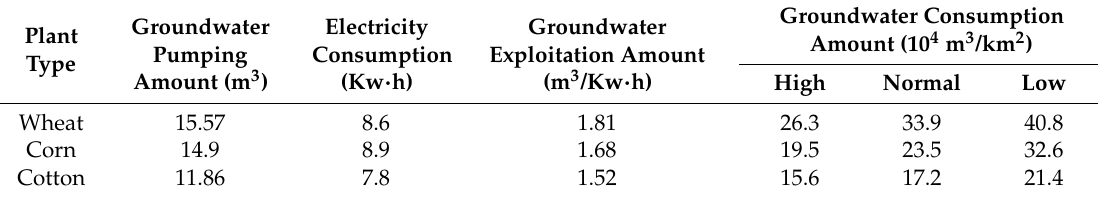
Table 3. Results of pumping test in typical area of non-project